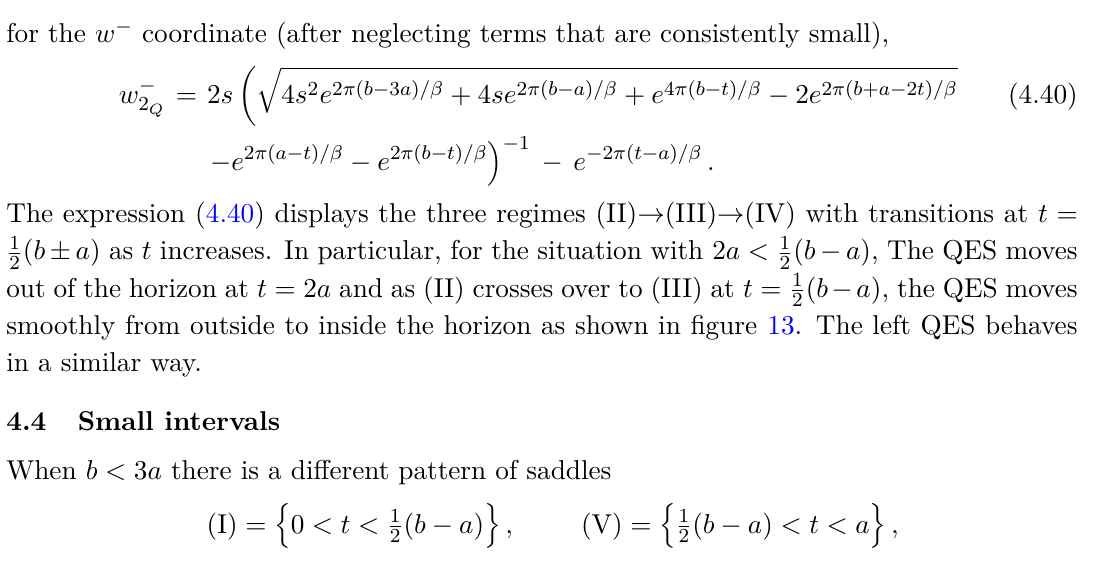
Figure 13 . The w − coordinate of the right QES determined numerically with some large but 2 Q finite temperature. When 2 a < 1 ( b − a ) (left panel), the QES starts off inside the horizon, exits at 2 t = 2 a at the onset of regime (II) and plunges back in at t = 1 ( b − a ) to remain inside in regime 2 (III), before saturating to the constant in region (IV). The situation when 2 a > 1 ( b − a ) (right 2 panel) shows the corresponding motion of the QES behind the horizon at all